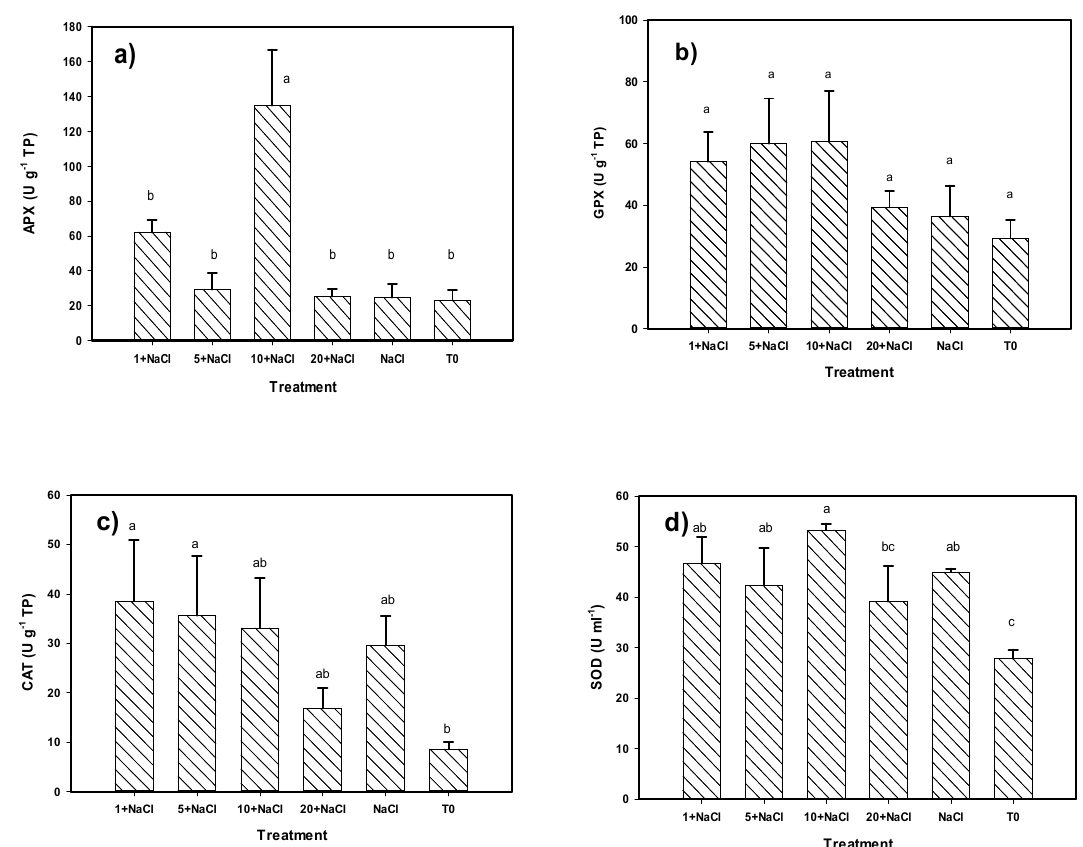
Figure 5. Enzymatic antioxidant compounds ( a ) APX, ( b ) GPX, ( c ) CAT, ( d ) SOD in tomato leaves under NaCl stress and an application of Se NPs. T0: Control. NaCl: NaCl-only treatment. The terms 1, 5, 10, and 20 + NaCl represent the amount of Se NPs applied (mg L − 1 ) plus 50 mM of NaCl. APX: Ascorbate peroxidase. GPX: Glutathione peroxidase. CAT: Catalase. SOD: Superoxide dismutase. TP: Total proteins. Di ff erent letters per bar indicate significant di ff erences according to Fisher’s least significant di ff erence test ( p < 0.05).